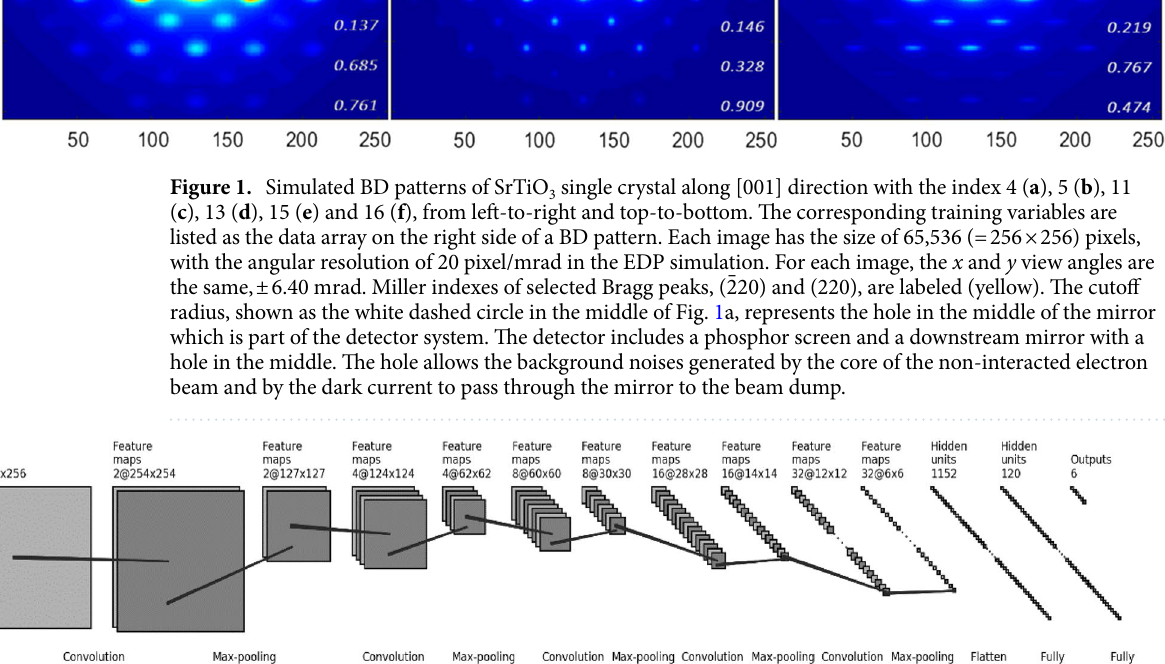
images from the test set are plotted in Fig. 3a–f, as the blue curves and orange crosses, respectively, and show reasonably good agreements except variable 5 ( ∆E / E ). Also, their corresponding error distributions regarding the whole image set are shown on the right side of Fig. 3a–f. Training loss (blue curve) and validation loss (orange curve) are plotted for two different cases, six training variables ( v 1 to v 6) trained together and only variable v 6 being trained, as Fig. 3g,h, respectively. It is clear to see that the generalization error of the prediction of variable 5 is about 10 times larger than the errors of variables 1—4, and 2 times larger than the error of variable 6. The generalization error is consistent with the RMS error of the randomly picked test images. However, training variable 5 corresponding to the beam energy spread is the most challenging parame- ter to be trained with a predictable result. The initial training was unsuccessful because the BD peak widths in every image are dominated by the normalized angular divergence, not by the energy spread in the EDP simulation. The BD peak width is the convolution of the normalized angular divergence �θ/θ and the energy spread � E / E : (cid:31) (�θ/θ) 2 + (� E / E ) 2 . In the first simulated dataset, the normalized angular divergence of